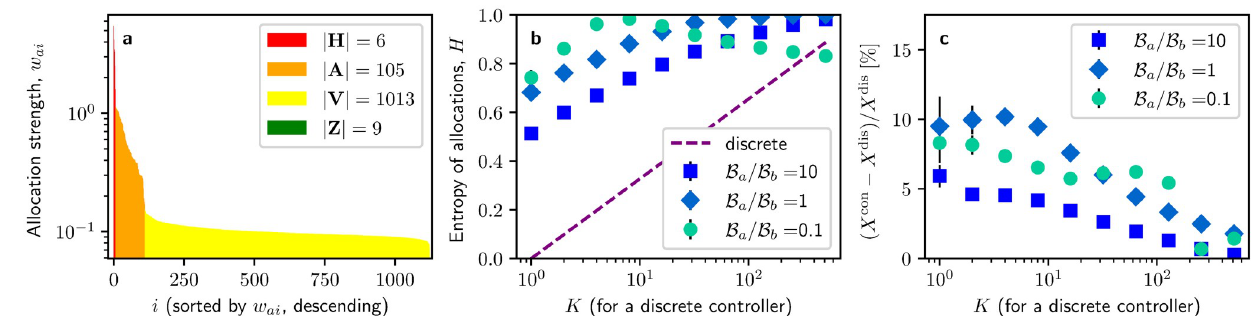
Fig 1. Preliminary exploration of the optimal influence profile in the continuous regime. a Distribution of optimal influence allocations sorted in descending order when the passive controller discretely targets K = 16 randomly chosen nodes and both controllers hold the same budget, B ¼ N h d i = 60 . Allocations are coloured by the allocation group they belong to. b Entropy of optimal allocation distributions in response to passive controllers with discrete allocations that are more or less widely spread (as measured by the number of nodes K that they target) and different budget ratios. The entropy of discrete allocations of the passive controller is also depicted ( dashed line ). c Percentage enhancement of control by optimal continuous allocations over optimal discrete allocations for varying K and budget ratios. Error bars represent standard errors over 15 experiment samples and the total budget of both þ B ¼ N h d i = 30 controllers sums up to B a b